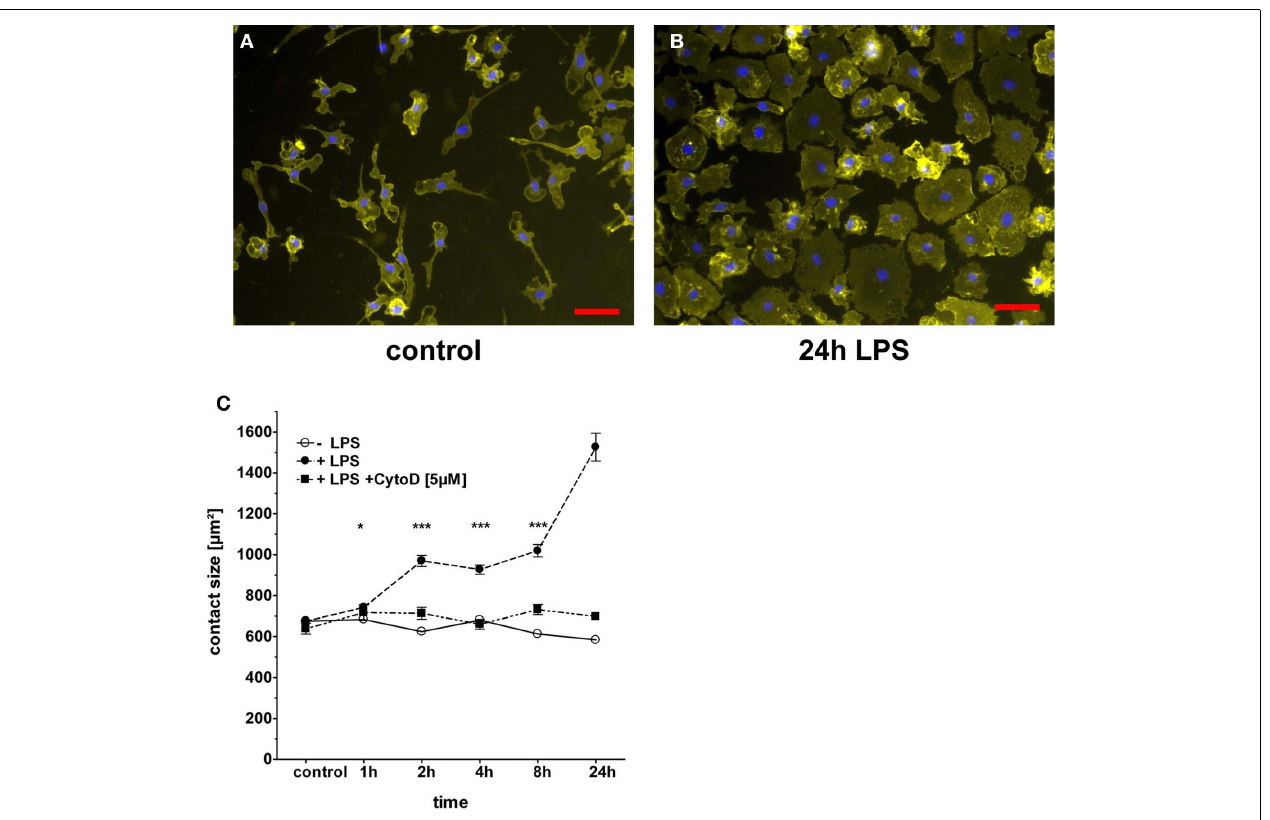
time points. Scale bar = 50 μ m. (C) Quantitation of cell spreading by manual annotation of CD11b staining. Shown are mean and SEM of at least 300cells per condition from one representative experiment. Media control (open circles), LPS (closed circles), and LPS in the presence of Cytochalasin D (closed squares). Statistical significance refers to LPS-treated compared to untreated condition. ns = not significant; * p < 0.05; *** p <